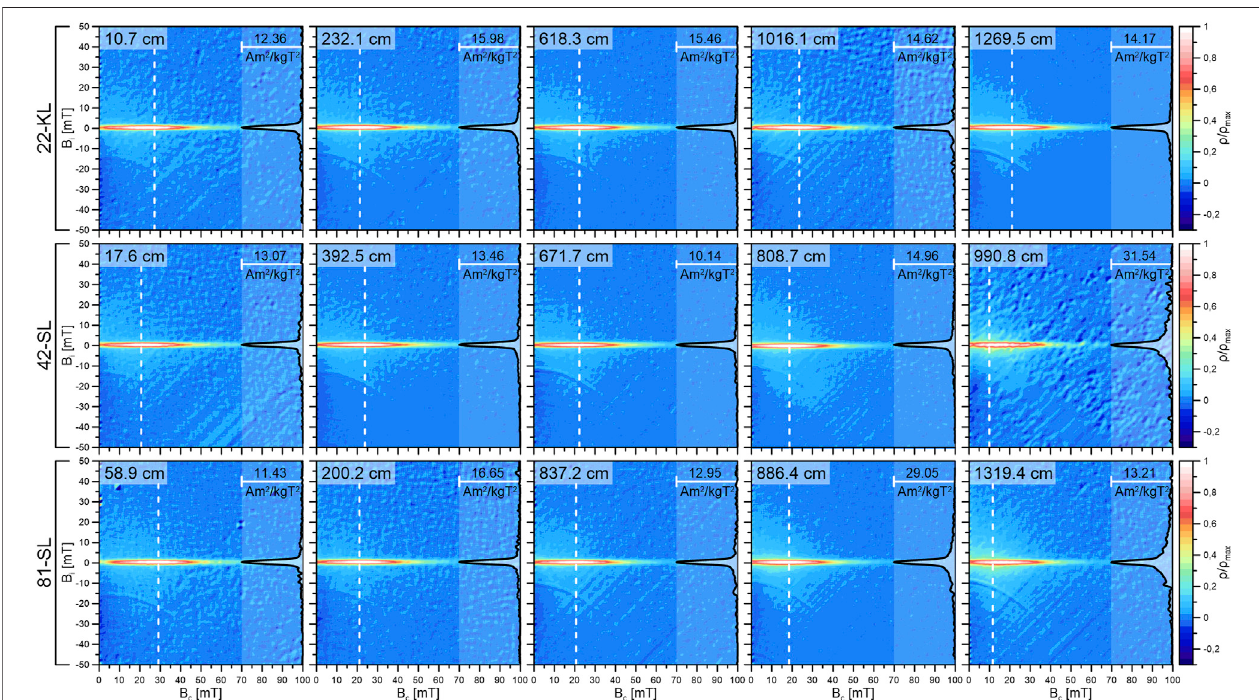
FIGURE 2 | Overview of selected FORC diagrams covering the full depth range at the three coring sites. The color scale of each diagram was normalized for improved comparability. Normalized pro fi les along the white dashed lines are displayed on the right side of each diagram. The pro fi le lines were chosen such that they intersect the FORC distribution at their peak values, The corresponding peak values are displayed in the upper left corner of each diagram. The FORC distributions at all threesitesaredominatedbyapronouncedcentral ridgeindicatingthatnon-interactingsingledomainparticlesarethemaincarrierofmagnetizationthroughoutthe whole